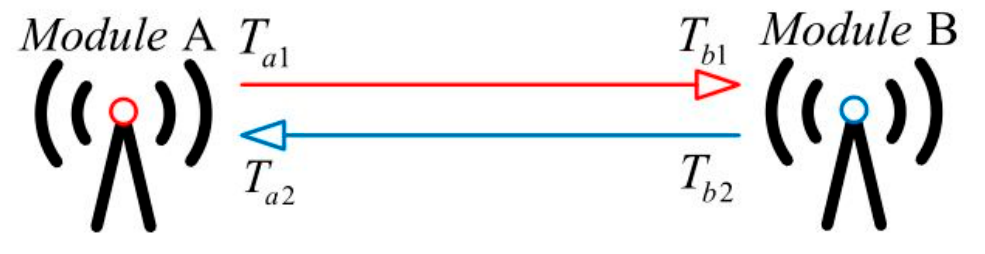
Figure 1. Two way-time of flight ranging principle.